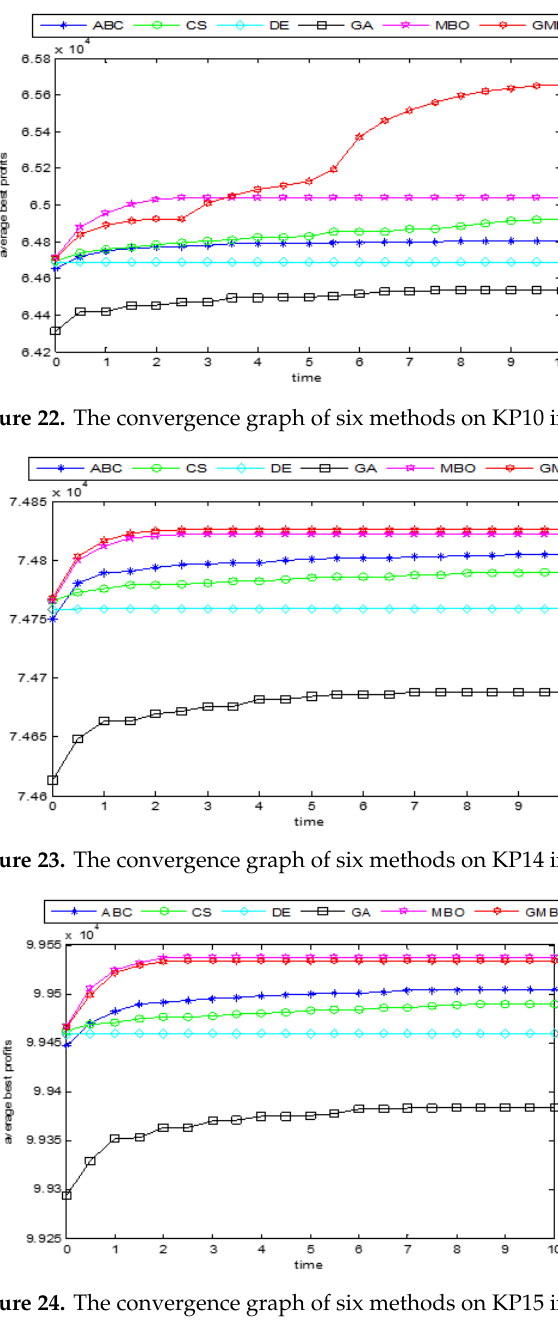
Figure 21. The convergence graph of six methods on KP9 in 10 seconds.